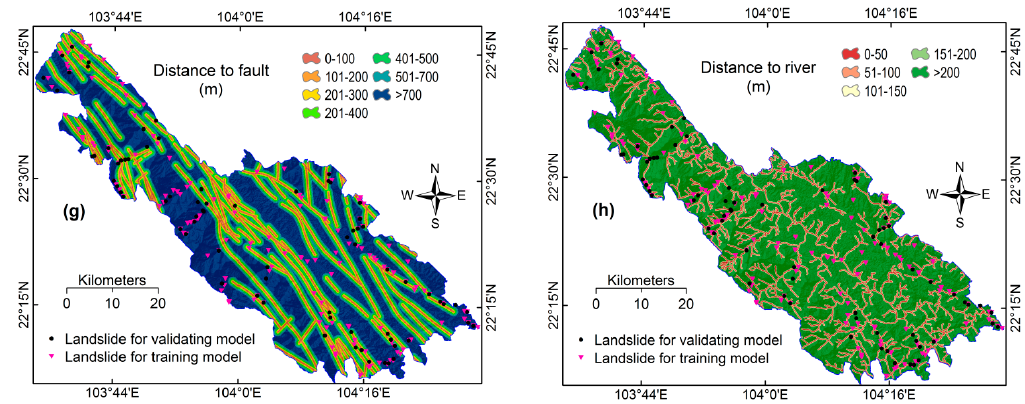
Figure 4. Landslide predisposing factors used in this study: ( a ) Slope; ( b ) Aspect; ( c ) Elevation; ( d ) Land cover; ( e ) Soil type ; ( f ) Lithology; ( g ) Distance to fault; and, ( h ) Distance to river. Soil type (e) legend : D : Sloping soil; Fl : Cultivated rice yellowish red soil; Fs : Yellowish red soil